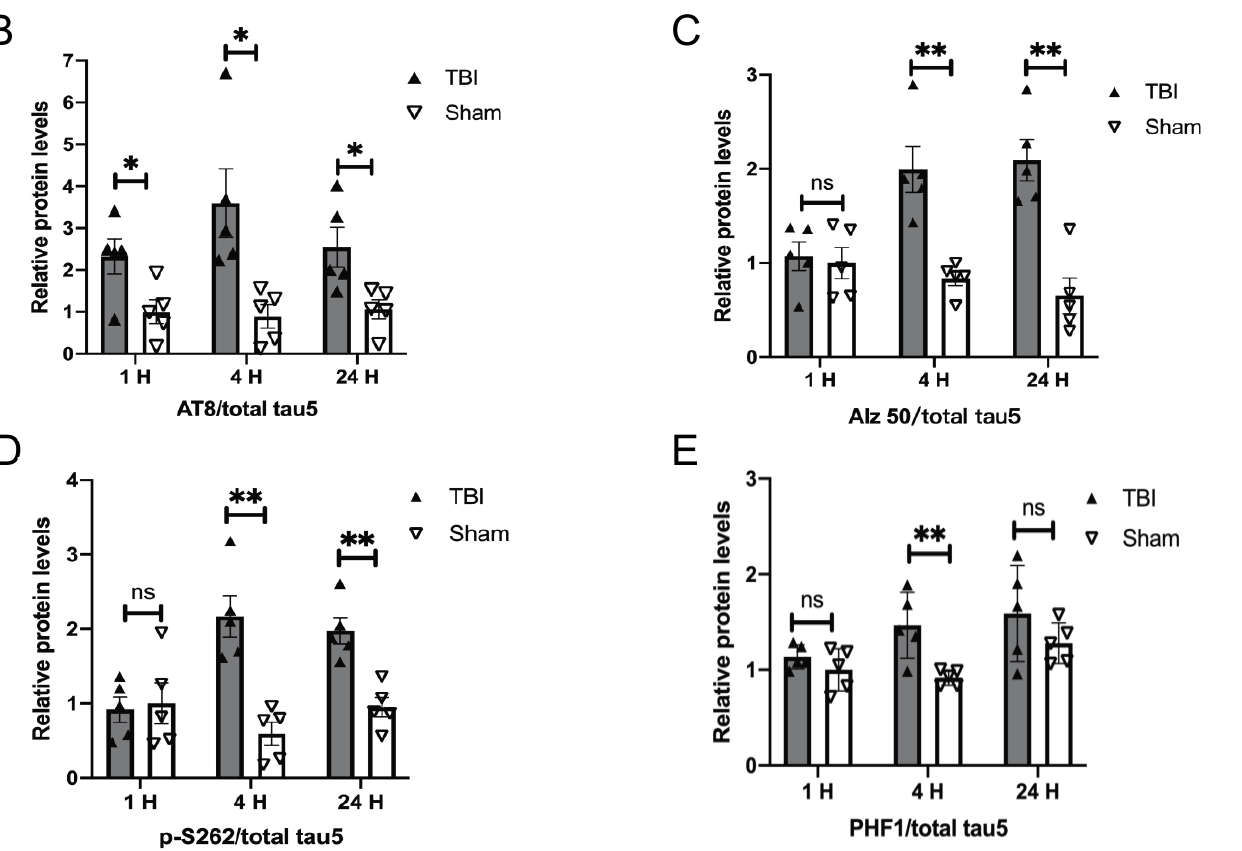
Figure 1. A single blast overpressure (BOP) caused increased tau phosphorylation in the mouse brain. ( A ) Representative Western blots demonstrated the early elevation of phospho-tau (Ser202/Thr205 detected by AT8, pS262, and Ser396/Ser404 detected by PHF1 antibody and pathological conformation changes of tau (Alz50) in the cortex after blast ( n = 5/group). Tau-5 was probed to detect total tau. ( B – E ) Quantification analysis of AT8 ( B ), Alz50 ( C ), pS262 ( D ), and PHF1 ( E ) normalized to total tau detected b they tau 5 antibody. (Data are means ± SEM, * p < 0.05, ** p < 0.01; ns, non-significant). TBI: traumatic brain injury.